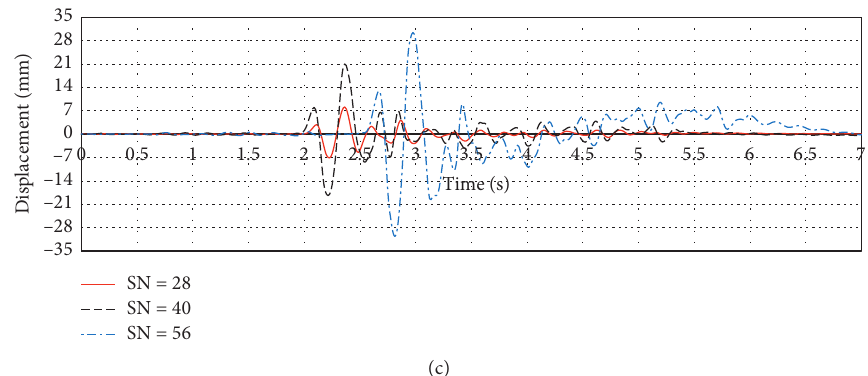
Figure 24: Time histories of the roof displacement of the specimen. (a) El Centro. (b) Shanghai. (c) Tianjin.